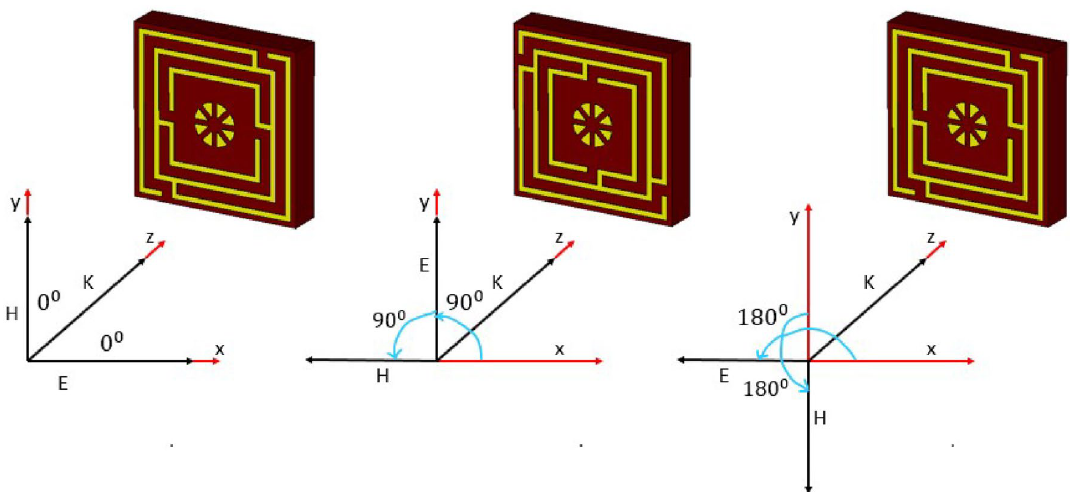
Figure 10. Polarization insensitivity at various angles of incidence (CST STUDIO SUITE 2019, https:// www. 3ds. com/ produ cts- servi ces/ simul ia/ produ cts/ cst- studio- suite) 39 .